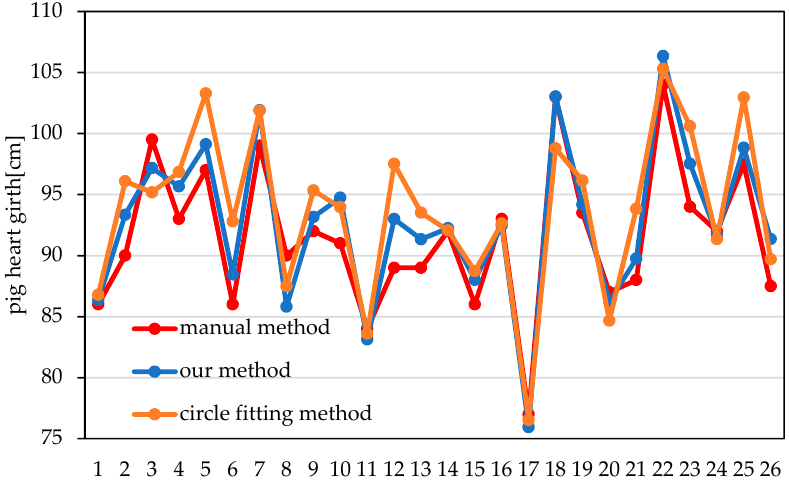
Figure 15. Pig heart girth measurements obtained using different methods.